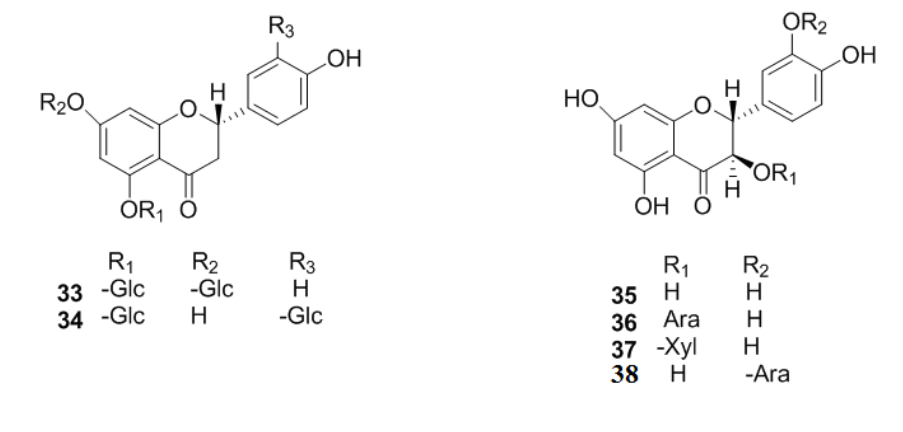
Figure 3. Chemical structures of flavanones and